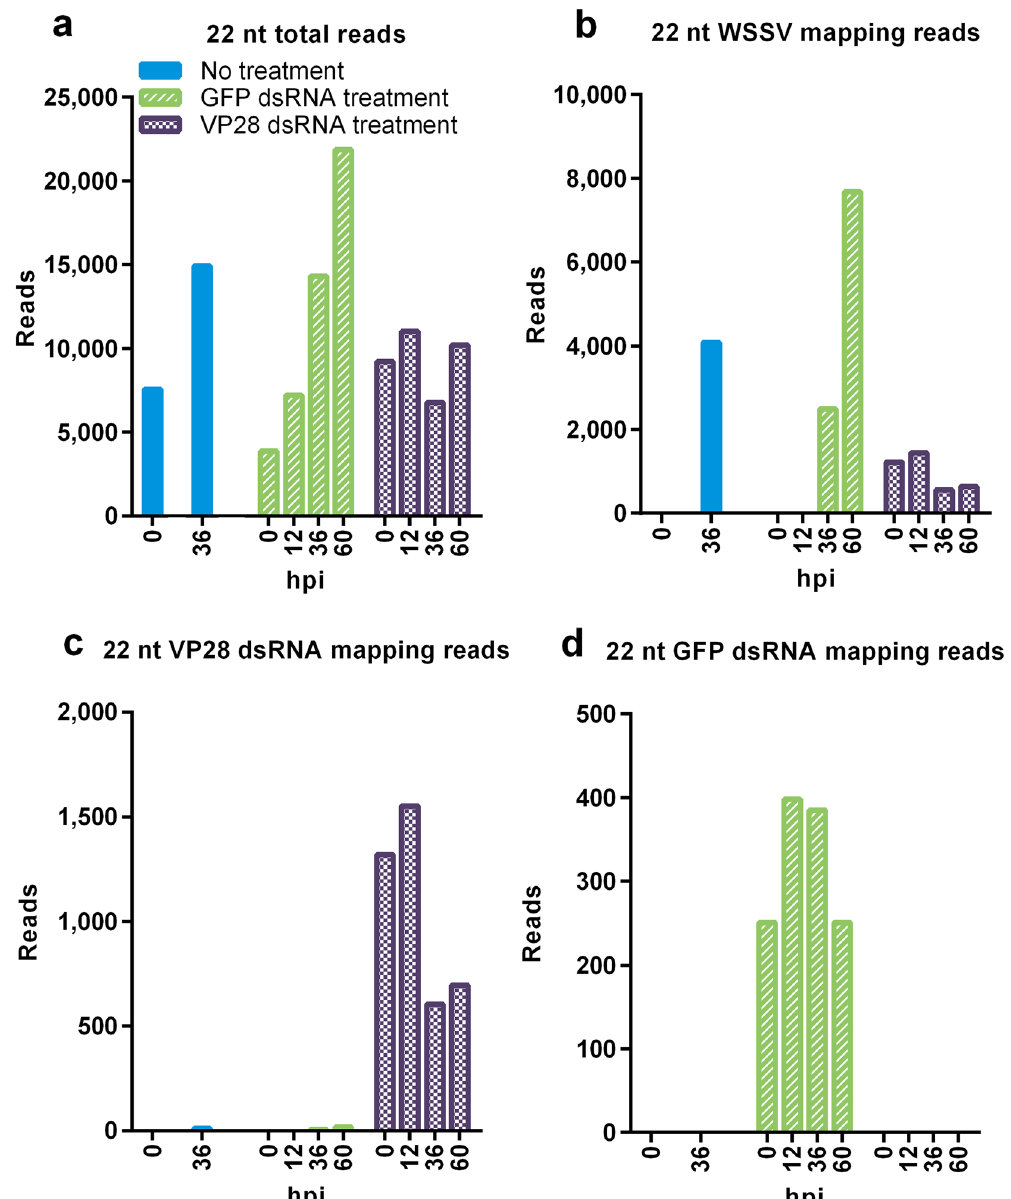
Figure 10. Mapping rate of 22 nt long siRNAs during WSSV infection. RNA was isolated from stomach tissue and equal amounts were pooled for each sample within a given group at a given time point. RNA sequencing was performed on these pools and 22 nt long reads were filtered out to be analyzed separately. ( a ) Represents 22 nt reads frequency among all available reads from each sample, ( b ) represents 22 nt reads frequency among reads mapping to a WSSV reference genome, ( c ) represents 22 nt reads frequency among reads mapping to the VP28 dsRNA treatment sequence, and ( d ) represents the 22 nt reads frequency among reads mapping to the GFP dsRNA sequence. The Y-axis represents reads per million total reads for a given sample